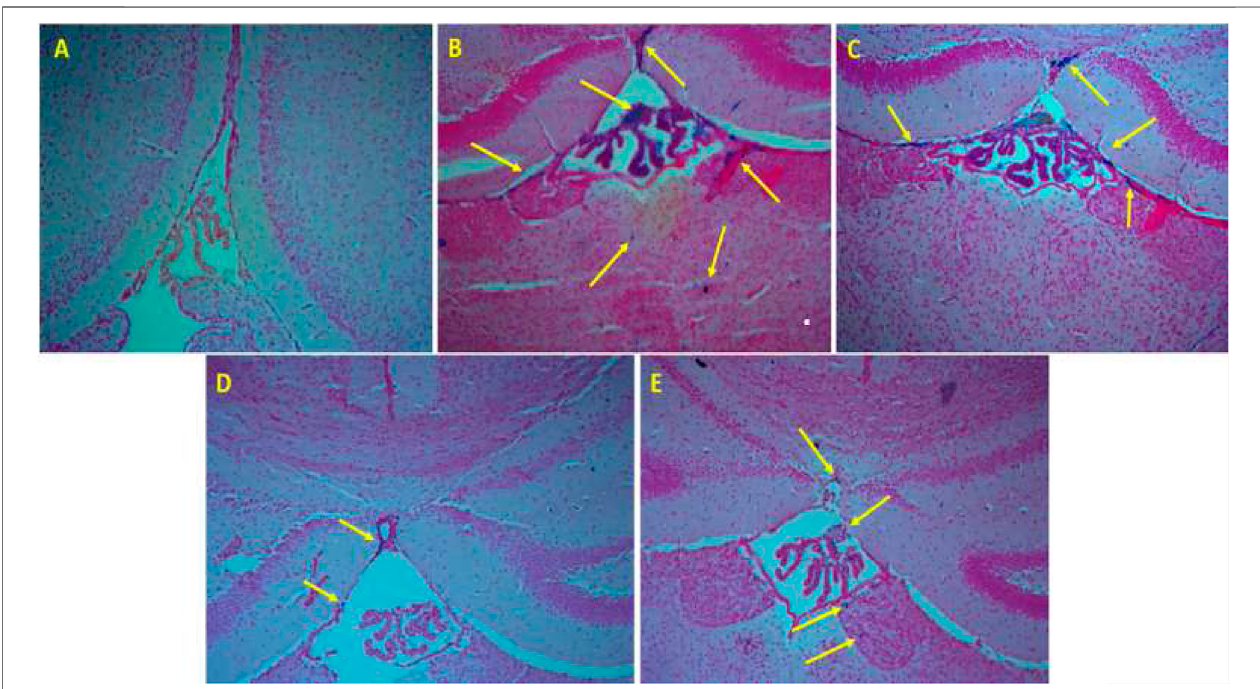
FIGURE 3 | Perl ’ s staining of the brain tissue. (A) The mice that were treated by normal saline, (B) the mice that were treated by iron dextran, (C) iron-overloaded mice that were treated by DFO, (D) iron-overloaded mice that were treated by naringin 30 mg/kg/day, and (E) iron-overloaded mice that were treated by naringin 60